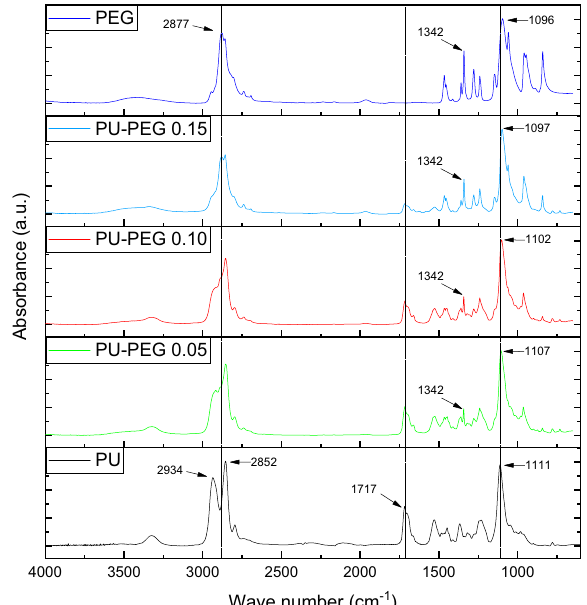
Fig. 2 FTIR-ATR spectra of the PU fi lms and PEG. As the graft density is increased the spectra of the fi lms look more similar to PEG spectra, indicating that there is a higher amount of PEG chains